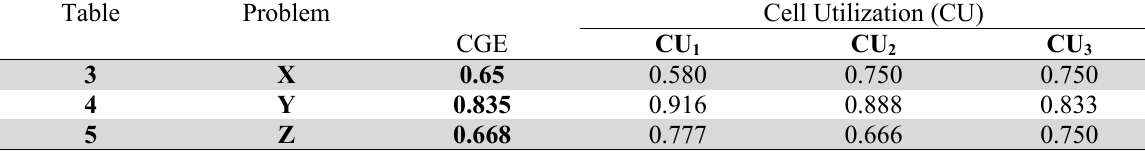
Efficiency of the system and Cell utilization using CGE for problem